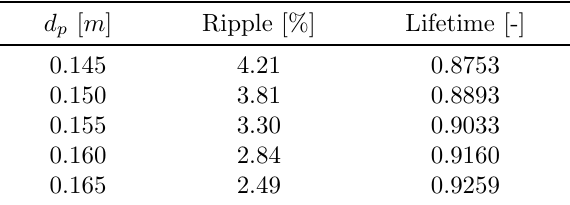
Table 12: Effect of hydraulic pipe diameter on ripples and gearbox lifetime